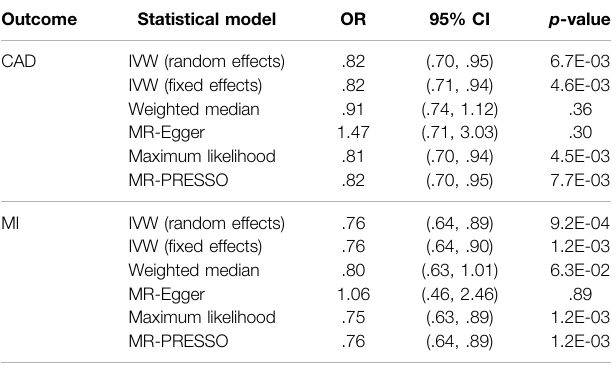
TABLE 1 | The associations between intelligence and coronary artery disease/ myocardial infarction using genetic data from the FinnGen study.